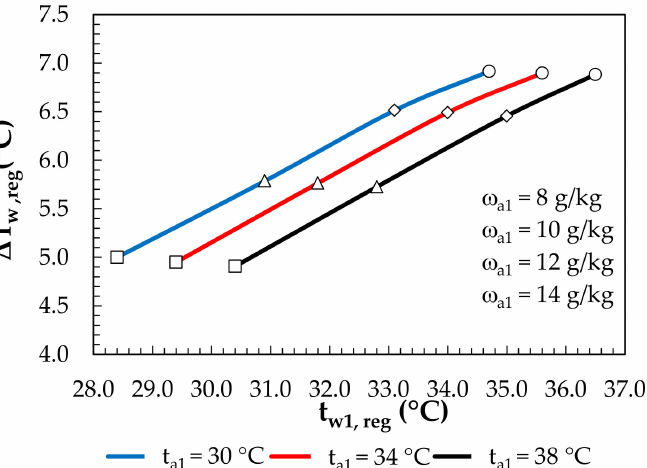
Figure 15. Water temperature drop in the MEC depending on the outdoor air parameters and inlet water